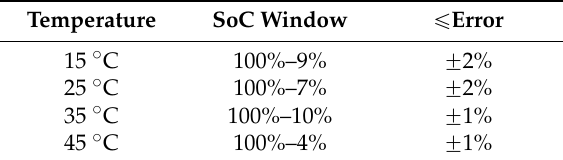
Figure 15. Dynamic behavior of the 1st order Thévenin Model measured and simulated DDP comparison at 25 °C with Coulomb counting and advanced characterization. Table 6. Results of the models where the SoC window is less than the proposed error.